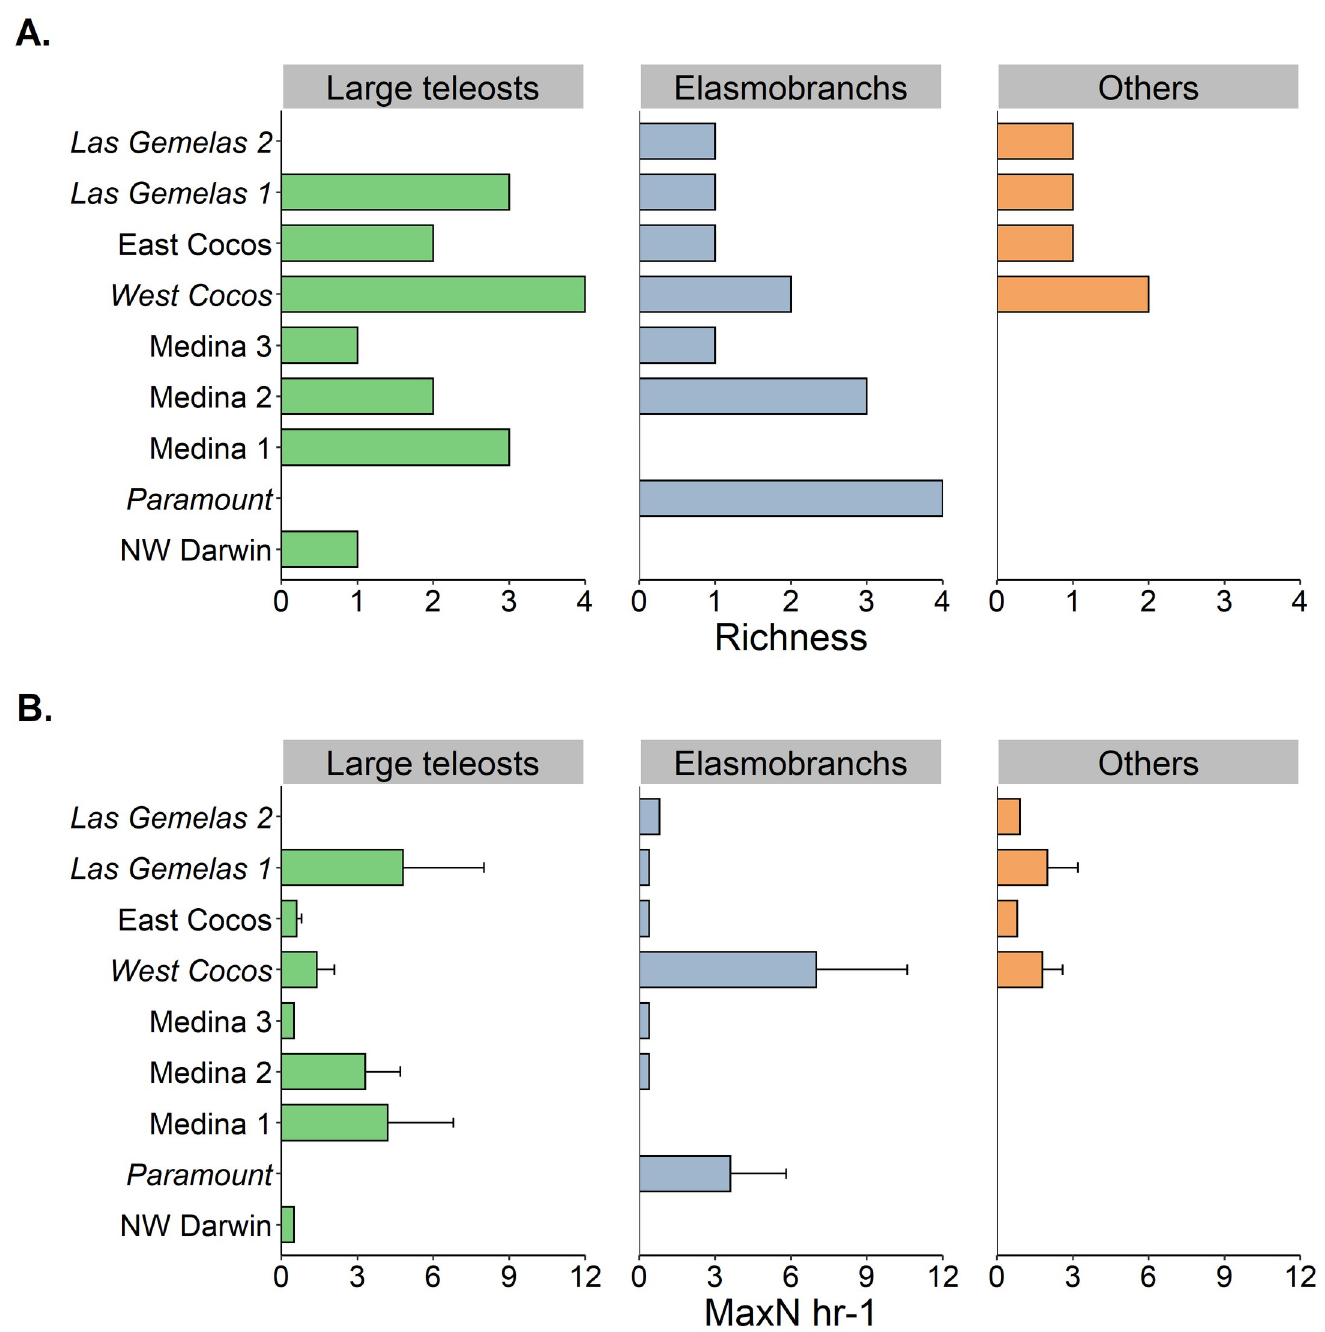
Fig 4. Comparison of (A) species richness and (B) relative abundance (MaxN hr -1 ) among ecological groups. Seamounts are ordered from bottom to top according to the distance from Galapagos Islands (bottom) to Cocos Island (top). Error bars represent the 95% confidence intervals. Shallow seamounts ( < 400 m) are shown in